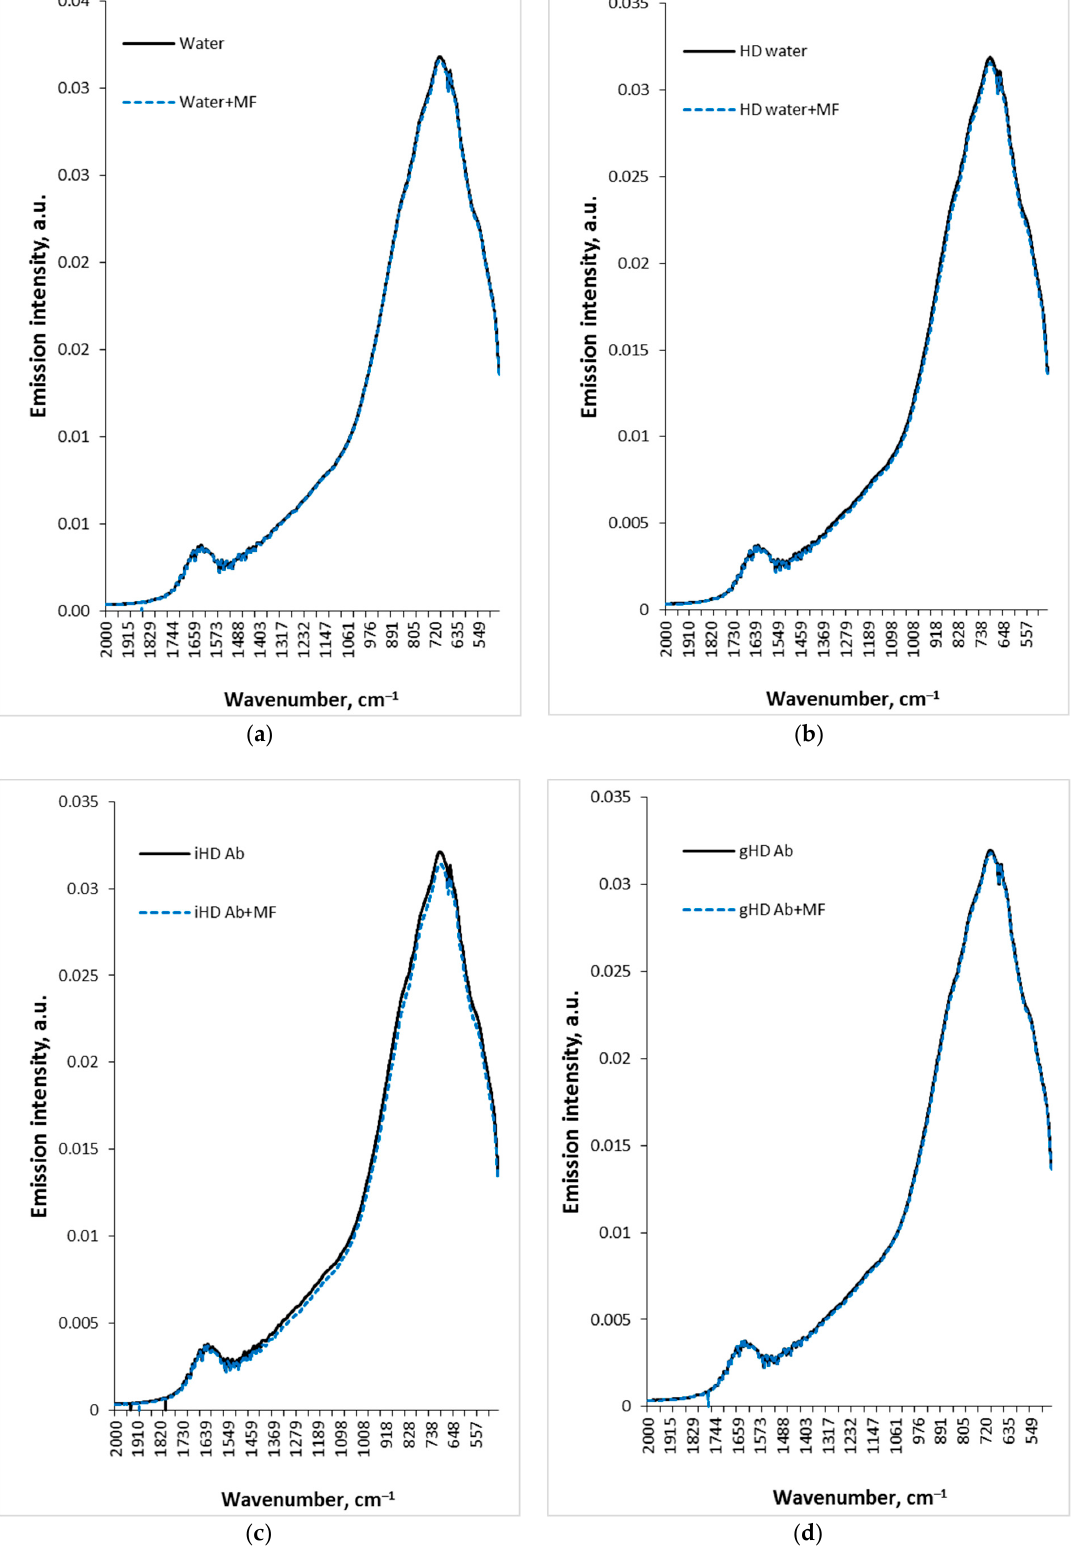
Figure 2. Emission spectra of samples in the range of 470–2000 cm − 1 before and after magnetic field treatment. ‘+MF’ indicates that the solution has been exposed to a magnetic field. ( a ) water, ( b ) HD water, ( c ) iHD Ab, and ( d ) gHD antibody.